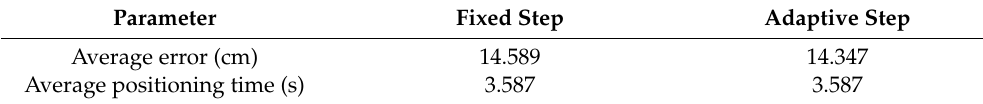
Table 11. Total average error and positioning time of the fixed and adaptive steps.